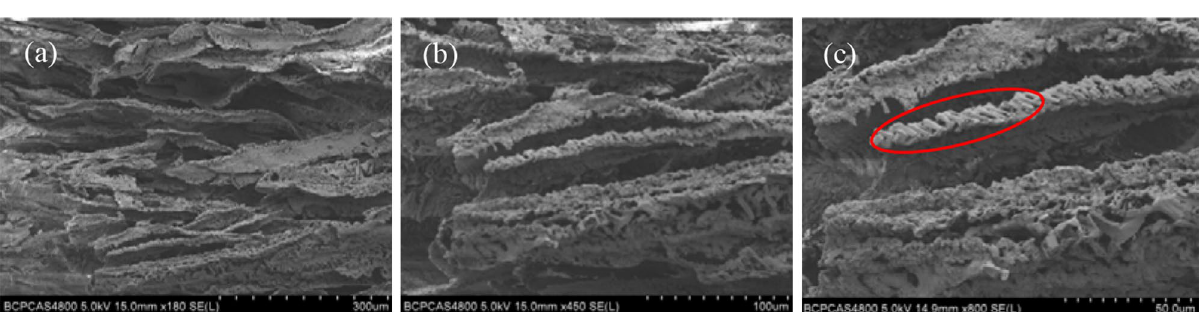
Figure 1. ( a-d ) Schematic illustration of preparation process of laminated AP composite.